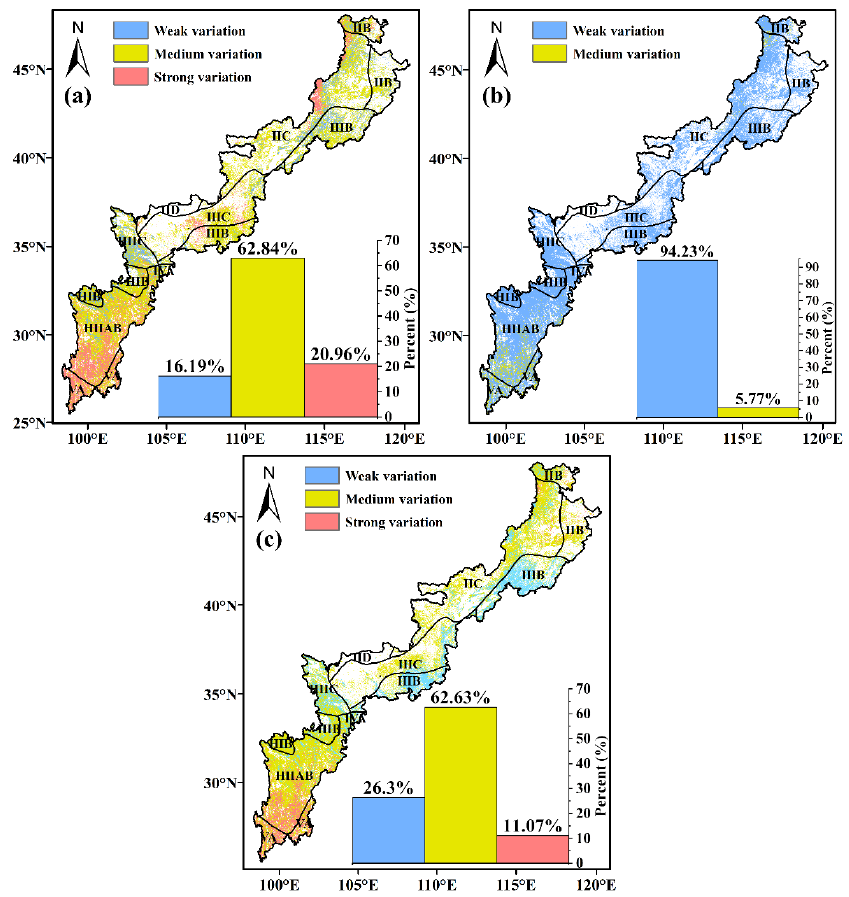
Figure 6. Spatial patterns of the vegetation phenological change stability in the agro-pasture eco- tone. ( a – c ) denote spatial patterns of the SOS ( a ), EOS ( b ), and LOS ( c ) stability, from 2000 to 2020, respectively.